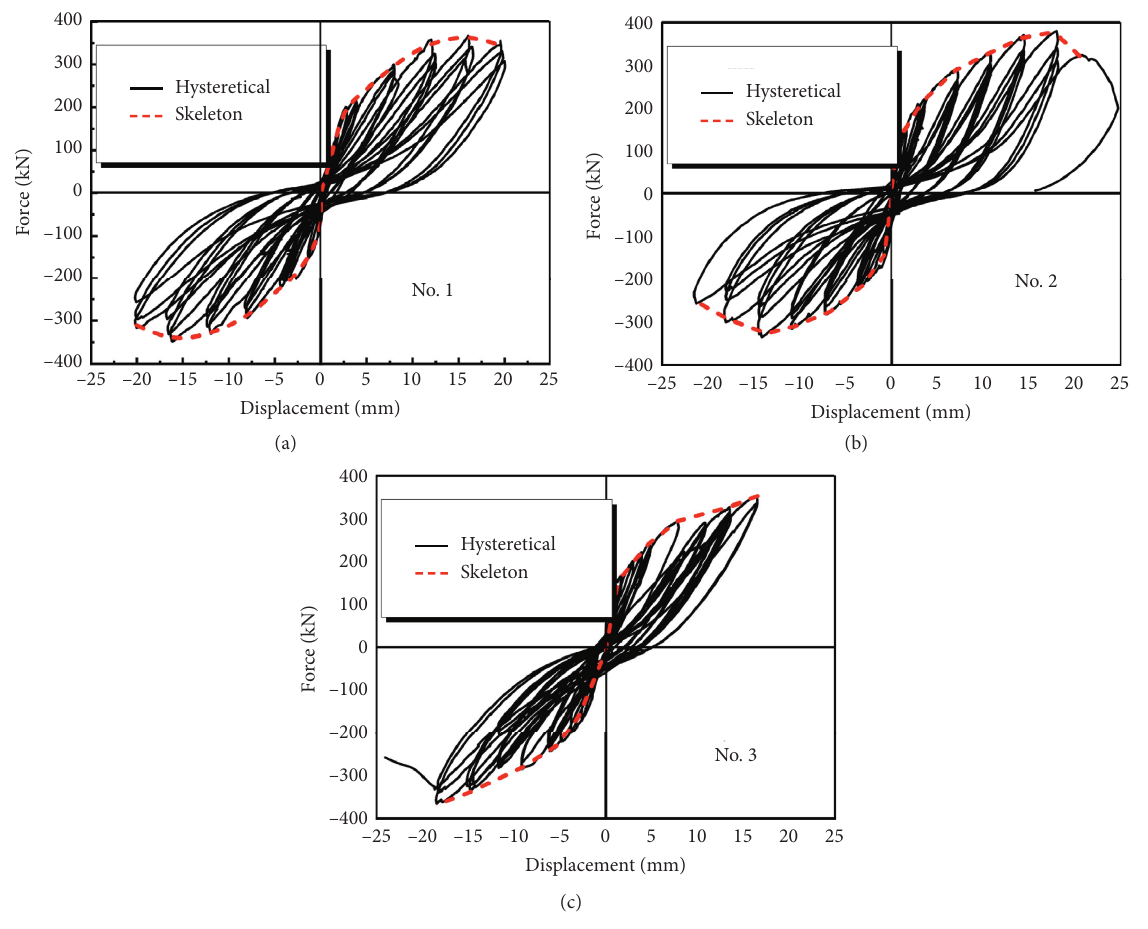
Figure 7: Hysteretic curves of thermal-insulation composite plates. Table 2: Force and